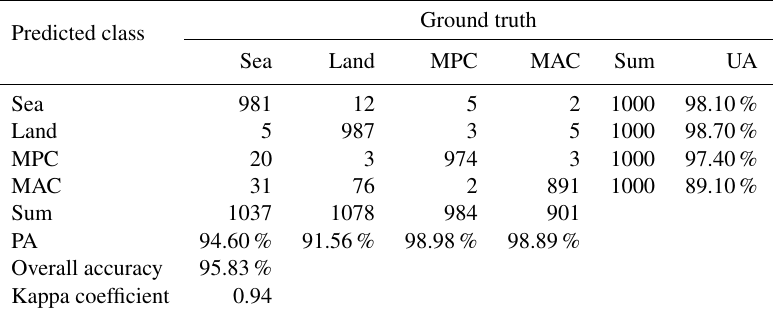
Table 2. Accuracy assessment of the classification results in China based on visual interpretation (pixels). (PA: producer accuracy; UA: user accuracy).